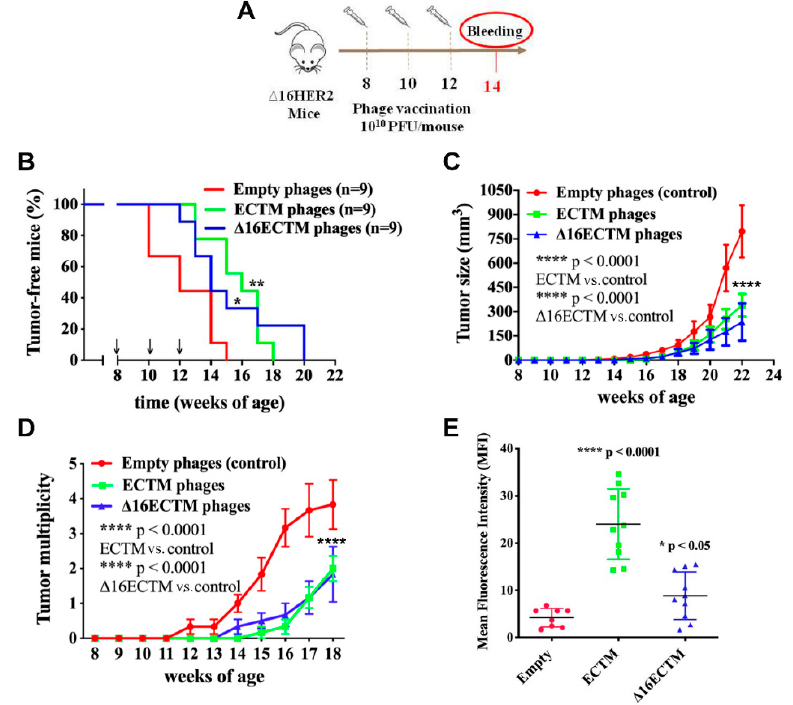
Figure 2. Phage-based vaccination against HER2+ BC in preventive experiment. ( A ). 10 10 (PFU/mouse) ECTM- or Δ 16ECTM- or empty-phage (control) vaccines were administered to ∆ 16HER2 mice at 8, 10 and 12 weeks of age, prior to tumor onset (n = 9 mice per group). Bleeding occurred at 14th week of age for sera analysis of anti-HER2-antibody titer. ( B ). Kaplan–Meier curves; Log Rank test (** p < 0.01 ECTM vs. empty phages; * p < 0.05 Δ 16ECTM vs. empty phages). ( C ). Tumor growth curves; Two-way ANOVA with Tukey’s multiple comparison test (**** p < 0.0001 control vs. ECTM; **** p < 0.0001 control vs. Δ 16ECTM). ( D ). Tumor multiplicity curves; Two-way ANOVA with Tukey’s multiple comparison test (**** p < 0.0001: ECTM vs. empty phages; Δ 16ECTM vs. empty phages). ( E ). Antibody detection. Sera of mice were analyzed by FACS using Δ 16HER2- HEK293 cells. Data represent Mean fluorescence intensity (MFI) ± SD; Student’s t -test (**** p < 0.0001 control vs. ECTM; * p < 0.05 Δ 16ECTM vs. control).